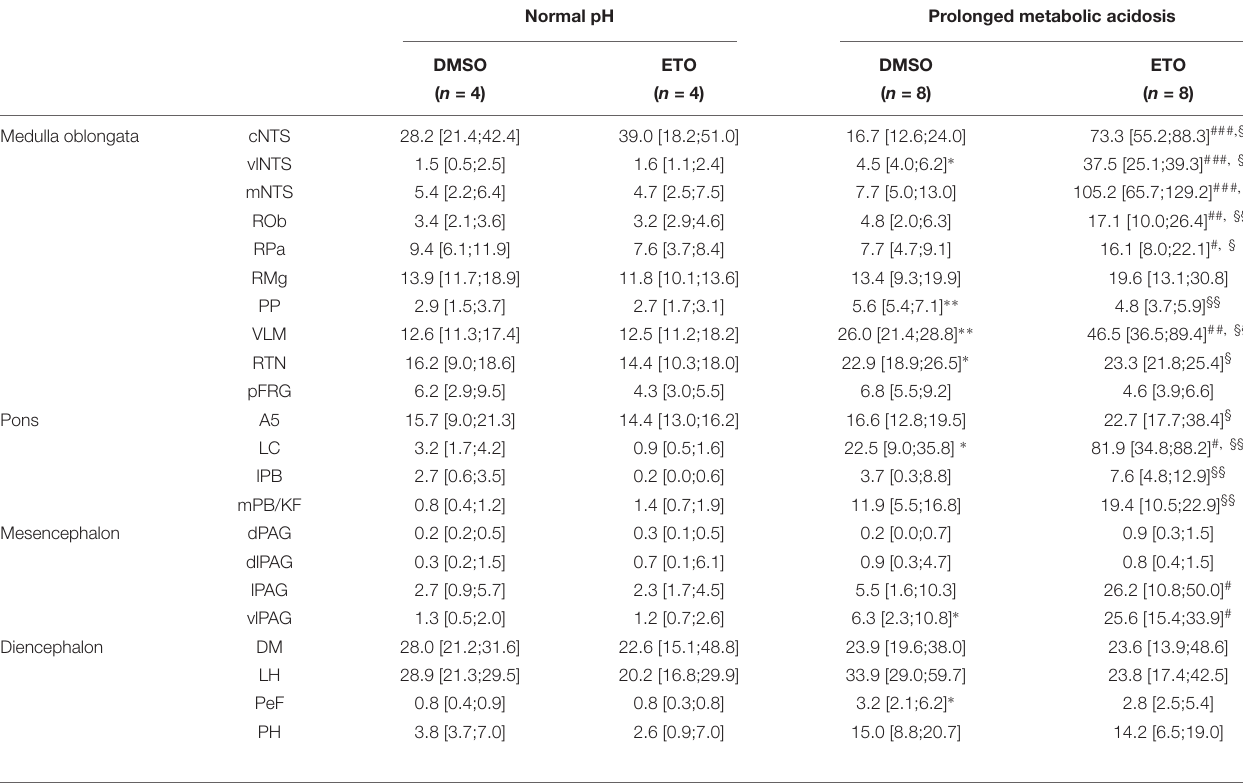
TABLE 1 | c-fos expression in brainstem and diencephalic structures of DBS ex vivo preparations under normal pH and prolonged metabolic acidosis conditions in the presence of either DMSO or etonogestrel. Normal